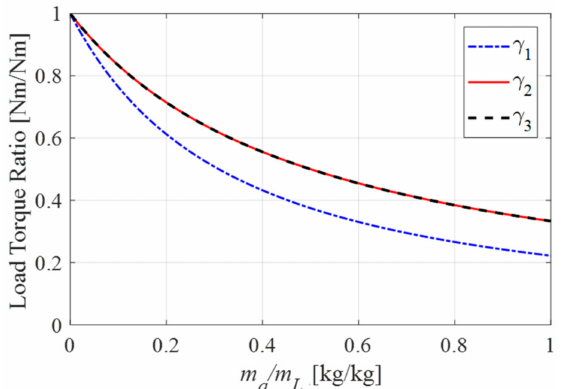
Figure 3. Load torque of the prior joint for the mass ratio m a / m L of the actuator module, including the link and cooling